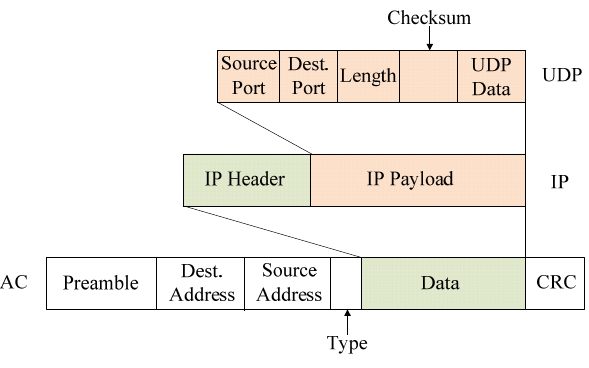
Figure 4. MAC frame format of PTP message.